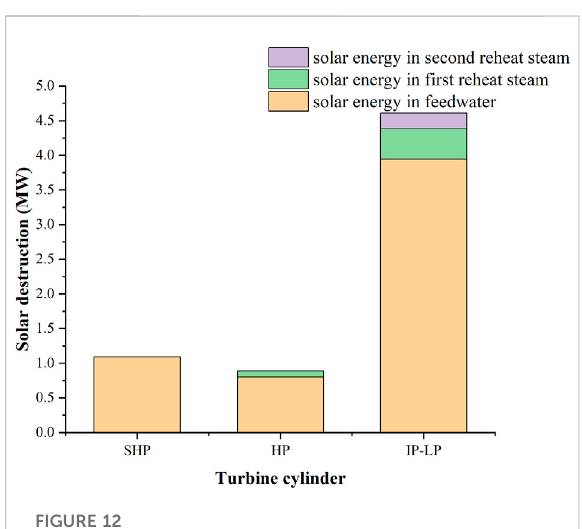
FIGURE 12 Solar exergy destruction in the turbine cylinder under 100% THA